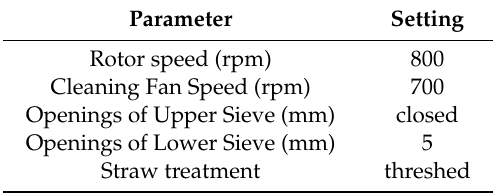
Table 2. Parameters for cost analysis. Parameter